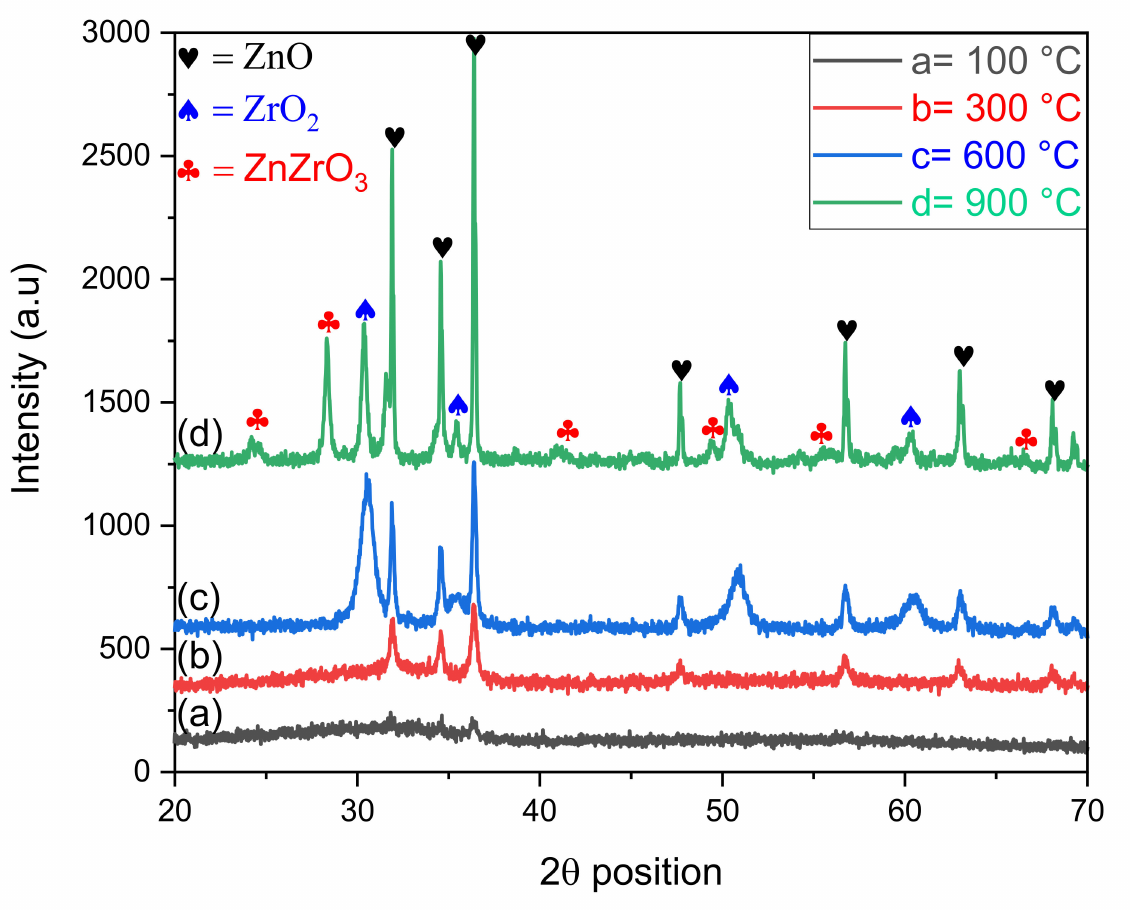
Figure 1. XRD patterns of ZnO-ZrO 2 NC calcined at different